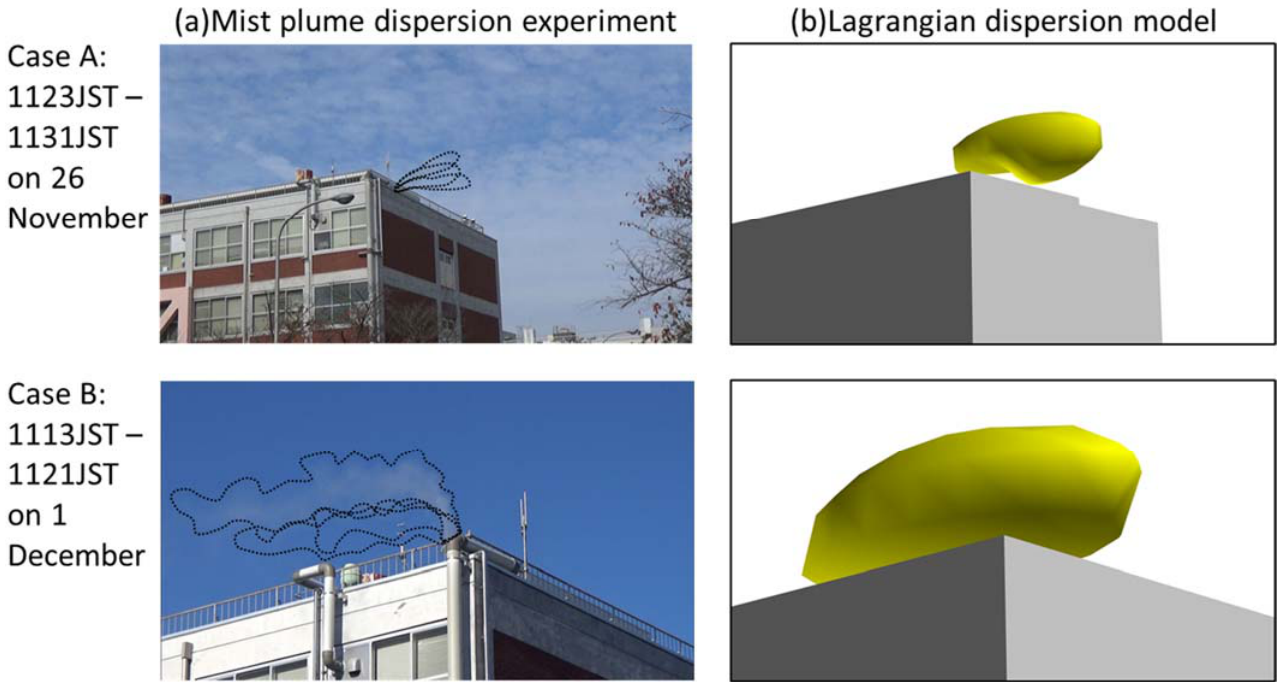
Figure 9. Instantaneous shots of the mist plume dispersion generated by the mist-spraying system at 3-min interval ( a ) and the simulated plume dispersion ( b ). The dashed line indicates the enveloping contour of the mist plume. The photograph was taken by the digital camera directed toward the mist-spraying system as shown in Figure 1. The yellow areas indicate the 50% iso-surface of initial concentration.